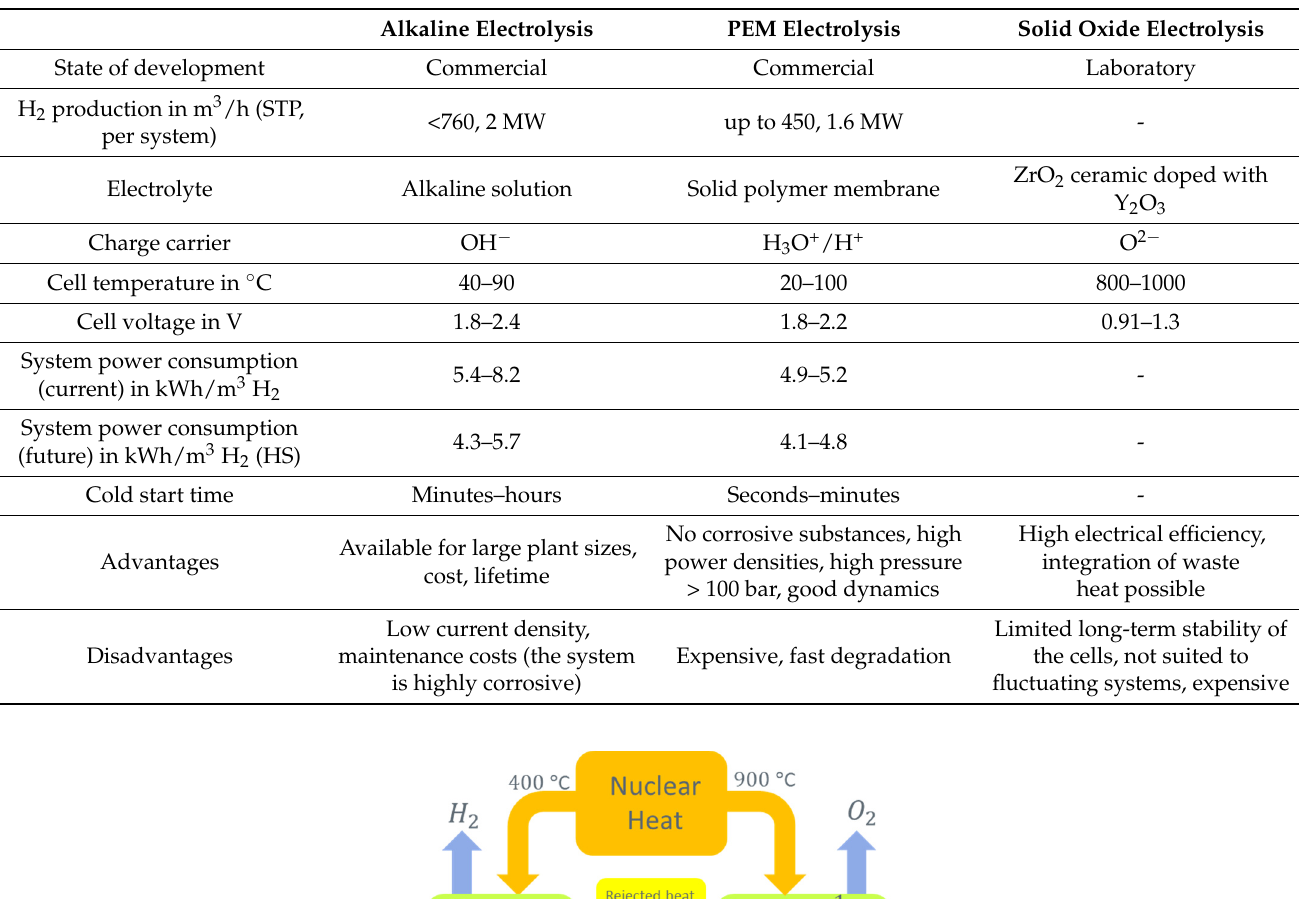
Table 4. Comparison between electrolyzers technologies [76].